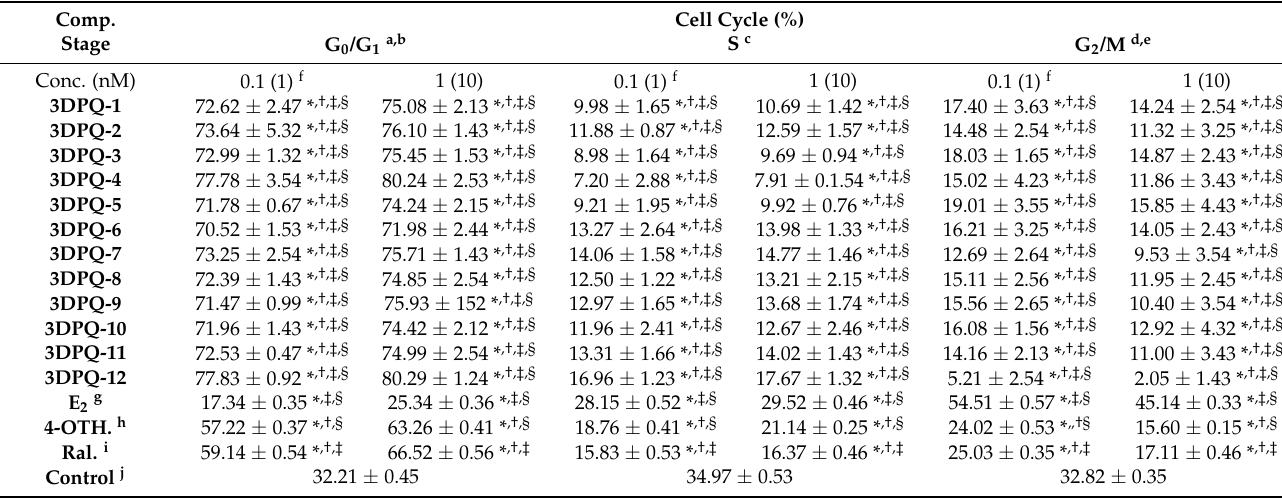
Table 9. Effects of synthesized compounds on the MCF-7 cell